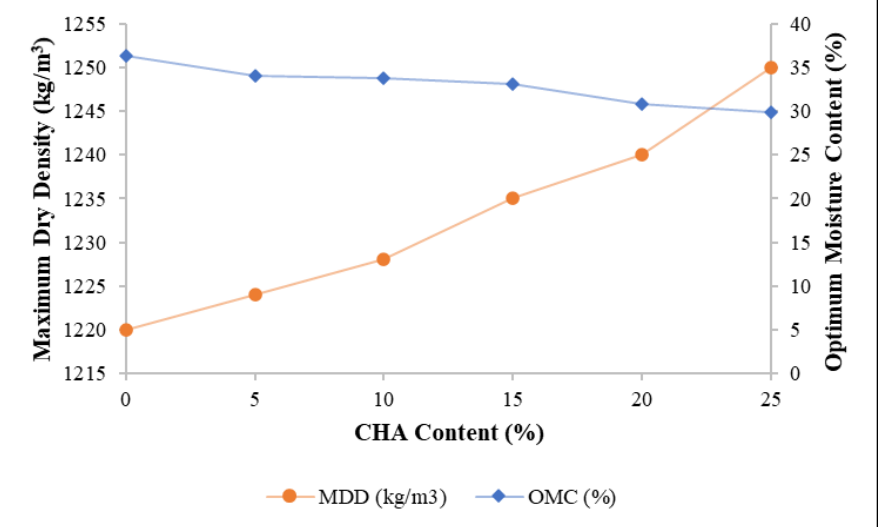
Figure 6. The specific gravity of the clay – CHA mixture.